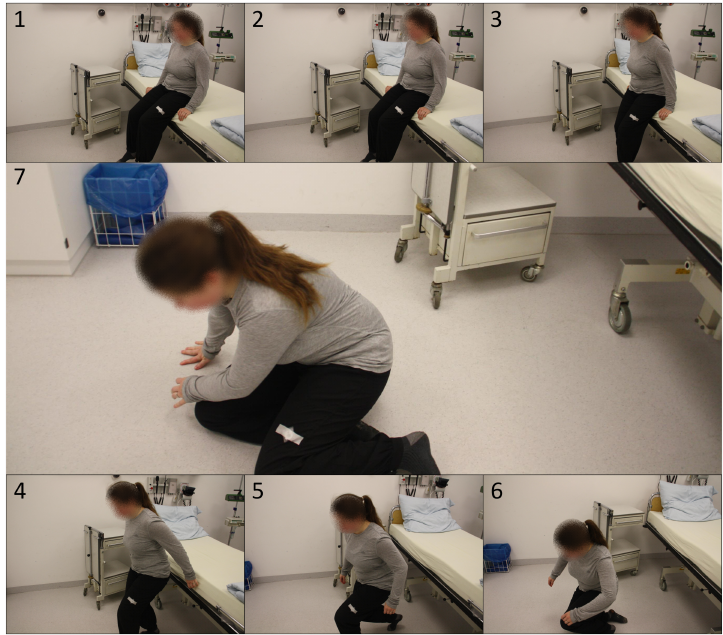
Figure 15. Procedure of a general fall, represented by a fall directly after an